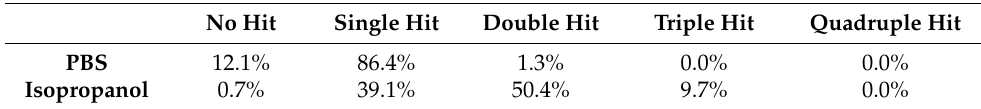
Table 4. Number of hits per objects for images acquired in PBS and in isopropanol for the binary